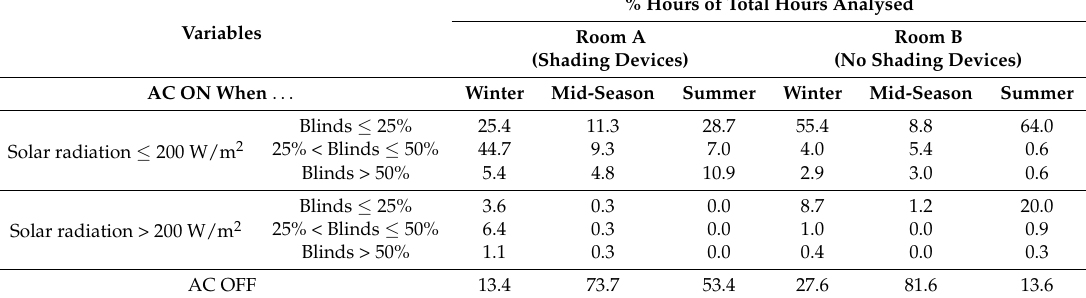
Table 6. Statistical analysis of the percentage of occupied hours in which the air conditioning system was ON, considering specific solar radiation and blind aperture levels. Data shown for each period and classroom analysed. % Hours of Total Hours Analysed Variables Room A Room B (Shading Devices) (No Shading Devices) AC ON When ... Winter Summer Solar radiation ≤ 200 W/m 2